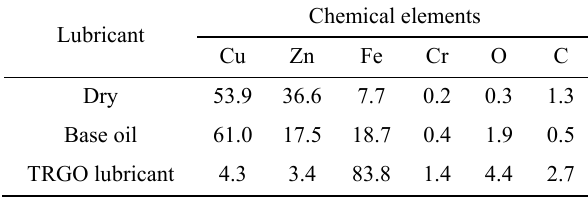
Fig. 8 SEM images of wear scars for (a)–(c) steel ball against (d)–(f) copper disk after friction tests in 3 N. Panels (a) and (d) are dry friction, (b) and (e) are the base oil, and (c) and (f) are with TRGO lubricant. Table 2 EDX analysis of wear scar on the surface of the steel ball after friction.